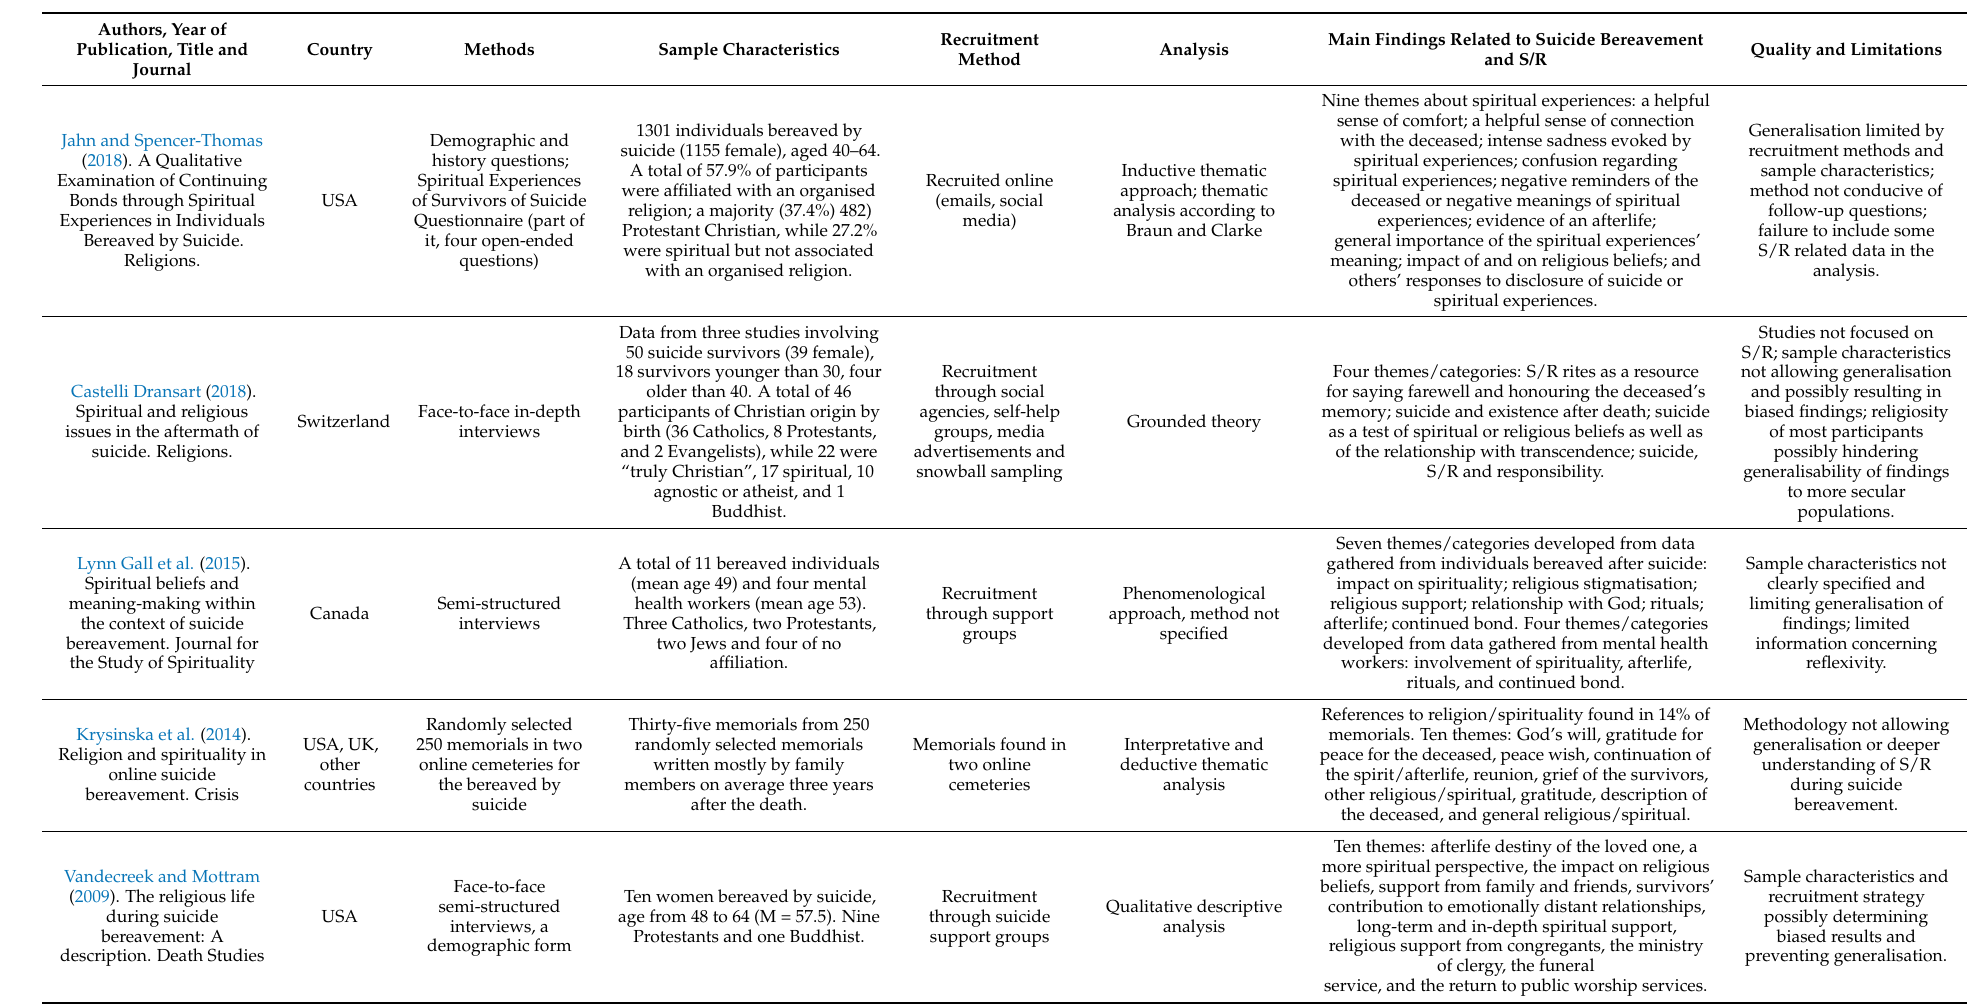
Table 2. Studies included in the